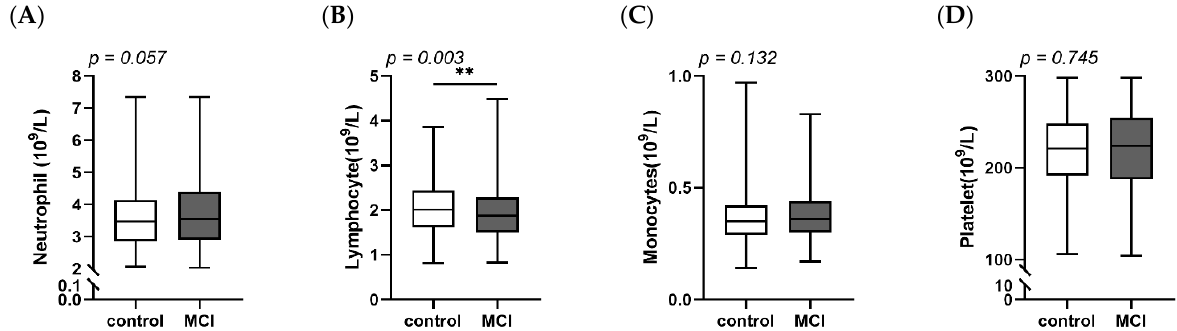
Figure 2. Concentration of inflammatory markers in blood between control and MCI. ( A ) Neutrophil counts; ( B ) Lymphocyte counts; ( C ) Monocytes counts; ( D ) Platelet counts. MCI, mild cognitive decline. ** p < 0.01.